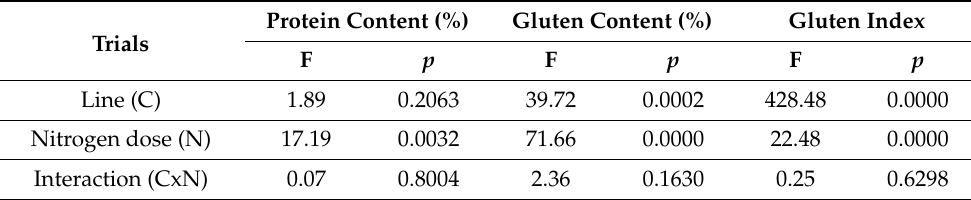
Table 1. Basic statistical parameters of the variability of the examined traits.